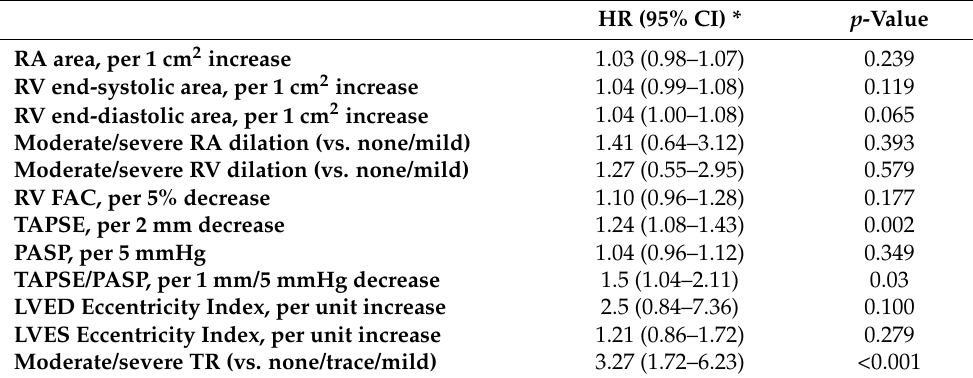
Table 4. Associations between Echocardiographic Parameters and